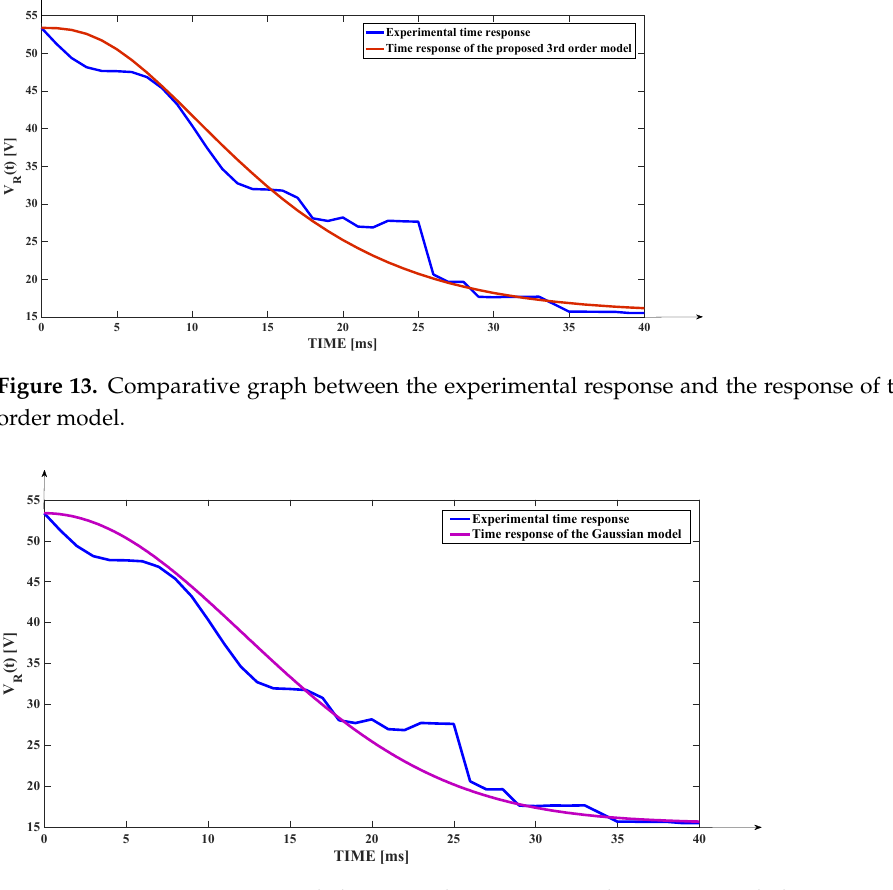
Figure 13. Comparative graph between the experimental response and the response of the third- order model.